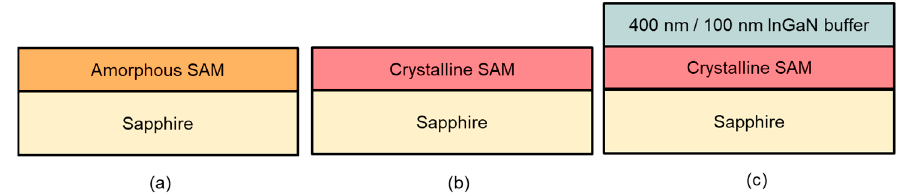
Figure 1. Cross-sectional schematics of ( a ) amorphous SAM deposited with RF magnetron sputtering, ( b ) crystallization of the SAM by annealing in a tube furnace, ( c ) subsequent MOCVD growth of InGaN.